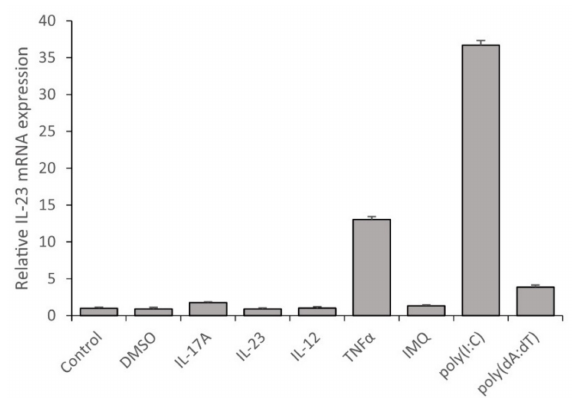
Figure 3. Synthetic nucleic acid analogues and TNF α induce IL-23 mRNA expression in NHEKs. Cells were transfected with 0.666 µ g/mL poly(I:C), 1 µ g/mL poly(dA:dT), 2 µ L DMSO, 1 µ g/mL IL-17A, 1 µ g/mL IL-23, 1 µ g/mL IL-12, 0.5 µ g/mL TNF α and 1.33 µ g/mL IMQ. Relative IL-23 mRNA expression was determined by the ∆∆ Ct method, normalized to GAPDH mRNA expression and compared to the expression of the untreated control samples. Results of one representative experiment are shown, data are presented as the average of three technical repetitions ±